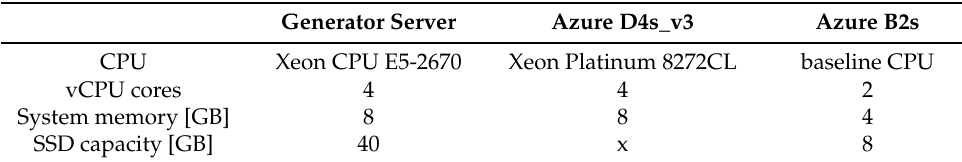
Table 1. Hardware equipment of used servers.